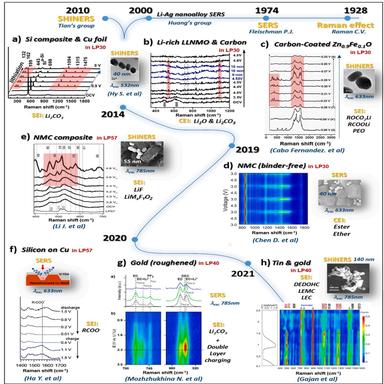
.2. SERS & SHINERS in situ / operando characterization of interfacial processes in LIBs: (a) SHINERS study (Au@SiO2 nanospheres) on silicon/C composite negative electrode; (b) SHINERS study (Au@SiO2 nanospheres) on Li-rich composite positive electrode; (c) SHINERS study (Au@SiO2 nanospheres) on Zn0.9Fe0.1O negative electrode; (d) SERS study (gold nanocubes) on (LiNi1/3Mn1/3Co1/3O2) (NMC 111); (e) SHINERS study (Au@SiO2 nanospheres) on (LiNi0.8Mn0.1Co0.